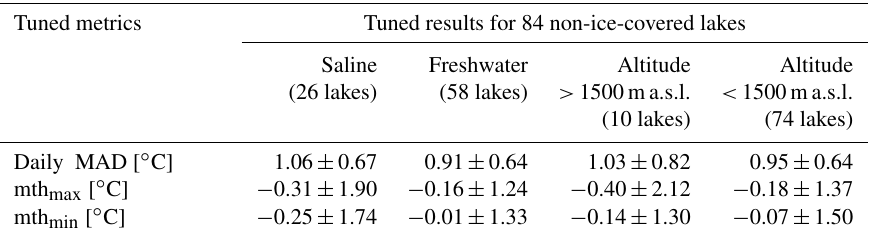
Table 8. Comparison of tuned metric results for saline, freshwater and high and low altitude non-ice-covered lakes, with the spread of differences across lakes, 2 σ . The metrics are explained in Table 4. Units are given in square brackets.